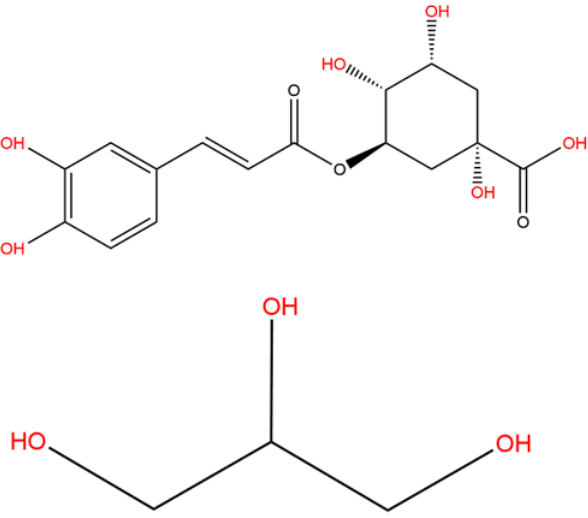
Figure 5. Molecular structure of chlorogenic acid and glycerol.